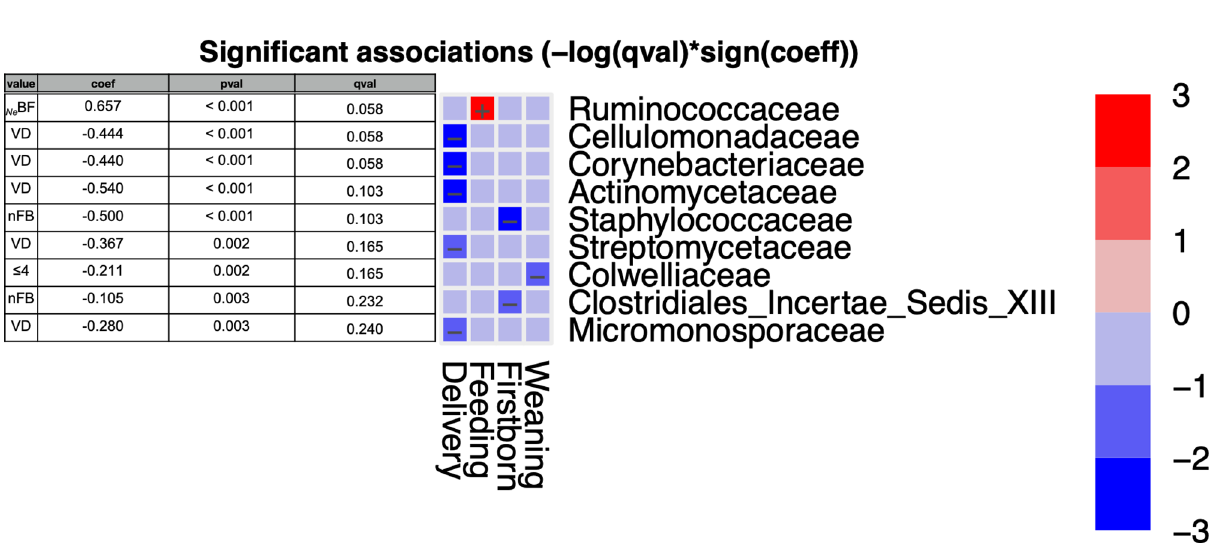
Frontiers in Cellular and Infection Microbiology |